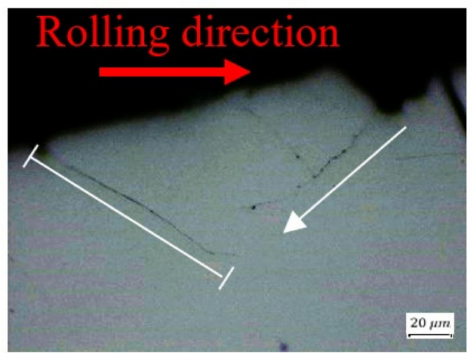
Figure 14. Microscope image of crack propagation within the spall. The white arrow and line represent the direction of crack propagation and arrested crack respectively.